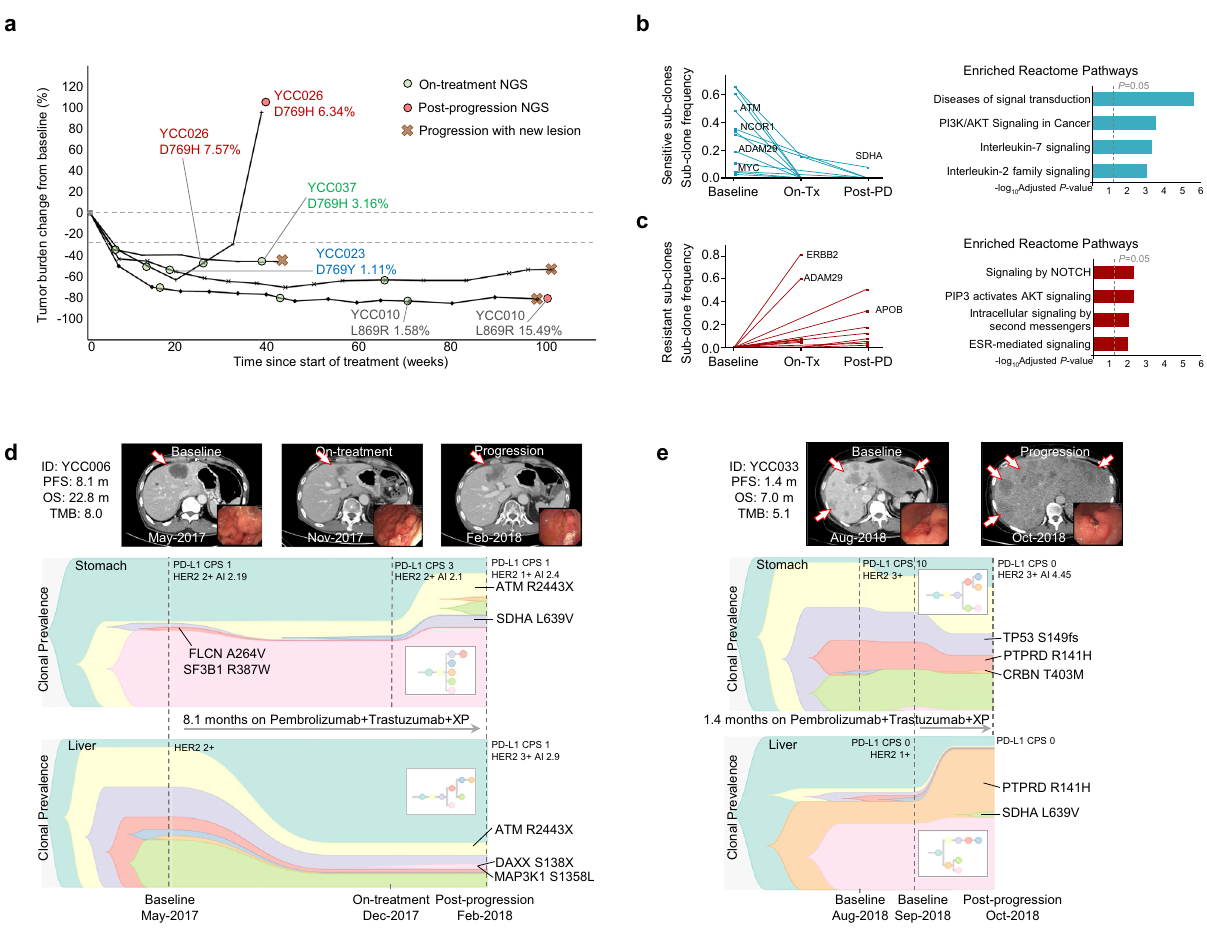
Fig. 5 | Genomic analyses from serial biopsy samples of HER2-positive gastric cancer patients treated with the fi rst-line quadruplet regimen. a Spider plot showing patients with HER2 mutations found in serial NGS analyses of primary tumor. Only cases with HER2 mutations and variant allele frequencies (VAFs) with the corresponding patient IDs are shown. b , c Sensitive ( b ) or resistant ( c ) sub-clones in which the sub-clone frequency changed over 2-fold in post- progression(Post-PD)samples( n = 10)oron-treatment(On-Tx)samples( n = 9) compared to paired baseline samples ( n = 14) are selected per patient. Statis- tically signi fi cant enriched Reactome pathways with the multiple test correc- tion (Benjamini-Hochberg procedure) were retained, and selected enriched Reactomepathwaysfromsensitiveorresistantsub-clonegenesarealsoshown.